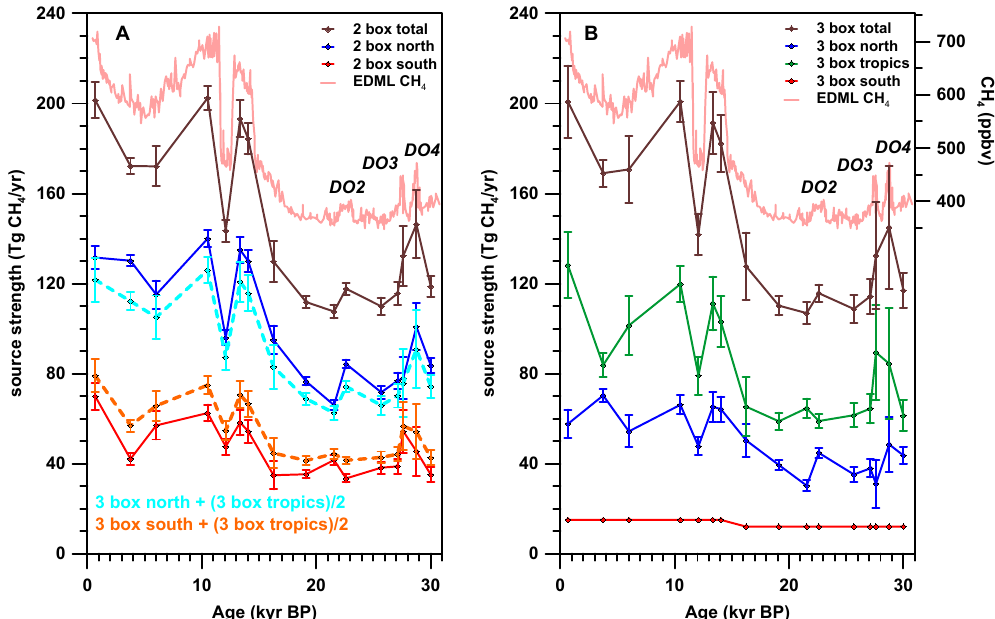
Fig. 5. Comparison of CH 4 source strength calculated with the three-box model and the two-box model. On the top of both panels the CH 4 concentration from EDML is shown for reference (light red). (A) CH 4 source strength calculated with two-box model. Brown: total source, blue: northern source, red: southern source, cyan: boreal source of the three-box model plus half of tropical source of the three-box model, and orange: southern source of the three-box model plus half of the tropical source of the three-box model. (B) CH 4 source strength calculated with three-box model (Chappellaz et al., 1997). Brown: total source, blue: northern source (30 ◦ N–90 ◦ N), green: tropical source (30 ◦ S–30 ◦ N), and red: southern source (90 ◦ S–30 ◦